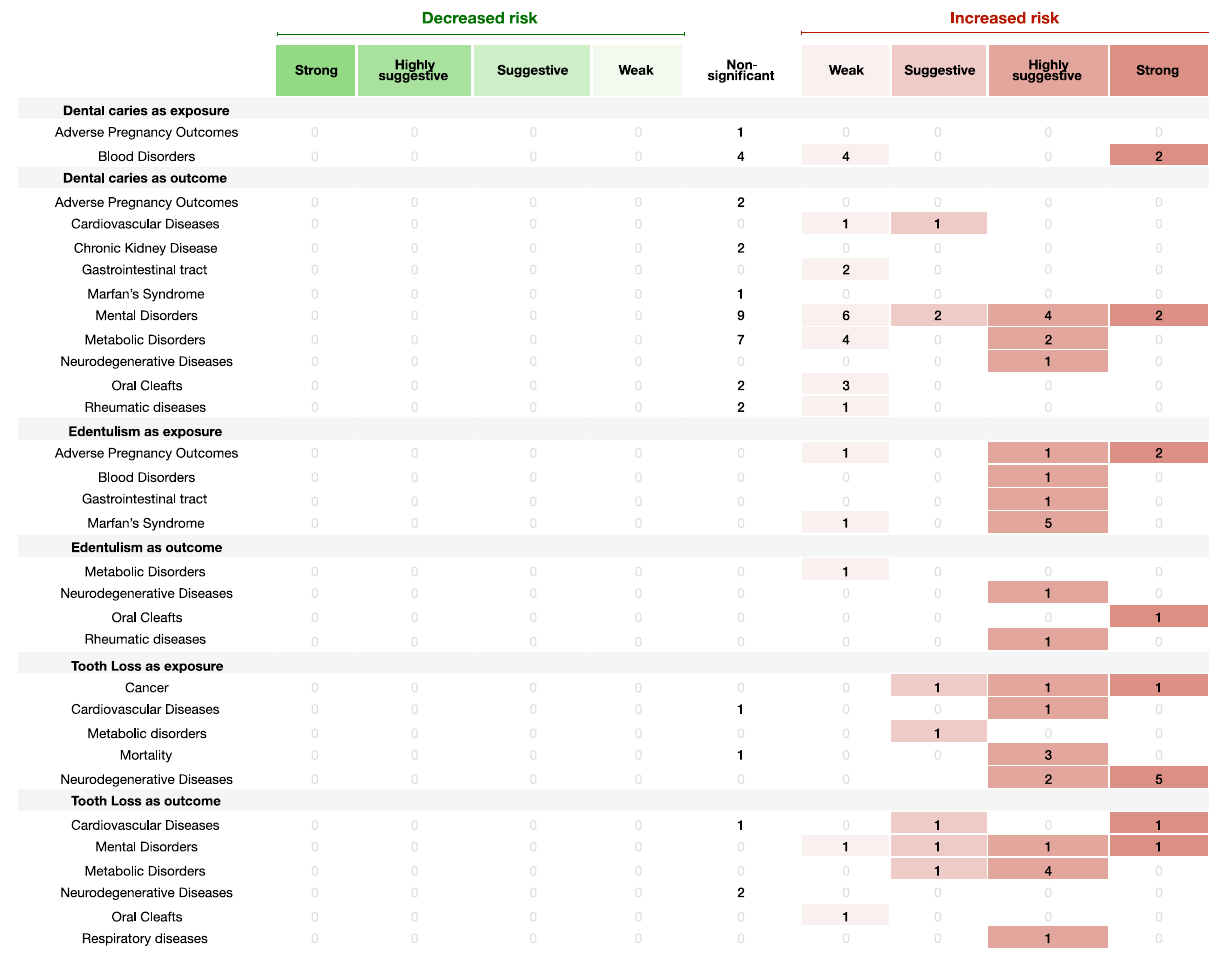
Fig. 2 | Evidence grading diagram on dental caries, edentulism and tooth loss (both as exposure and outcome) of an NCD. The right side displays associations that increase the risk for the respective NCD (in red), whereas the left side shows